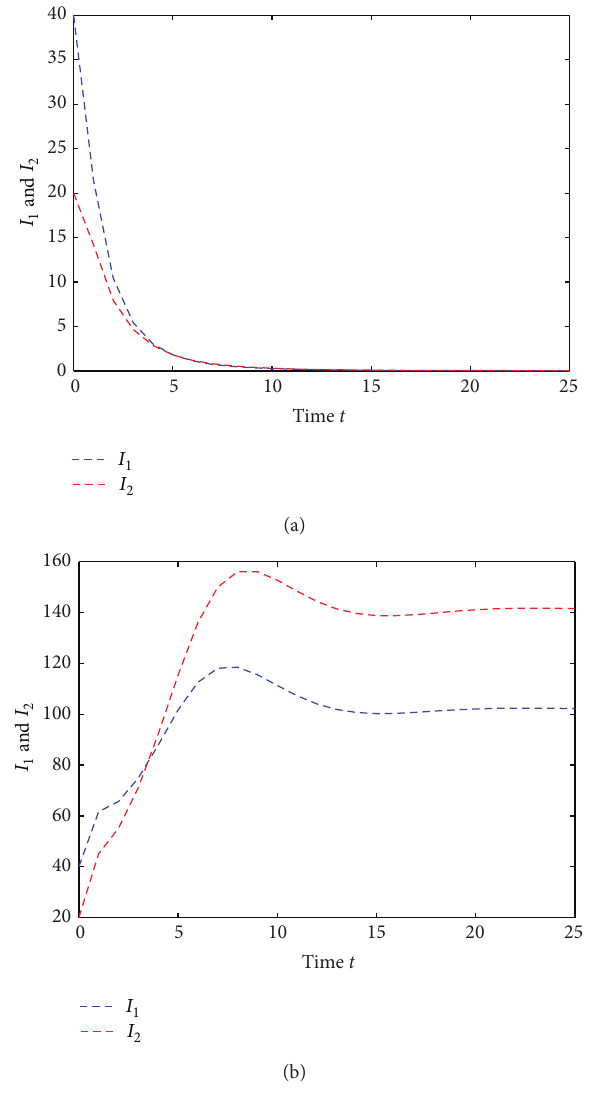
Figure 1: (a) The disease dies out in both groups. (b) The disease persists in both groups. Initial conditions are: 𝑆 1 (0) = 280 , 𝐼 1 (0) = (0) = 10 , 𝑉 (0) = 130 , 𝑊 (0) = 250 , 𝑆 40 , 𝑅 1 1 1 (0) = 10 , 𝑉 (0) = 130 , 𝑊 (0) = 300 𝑅 2 2 2